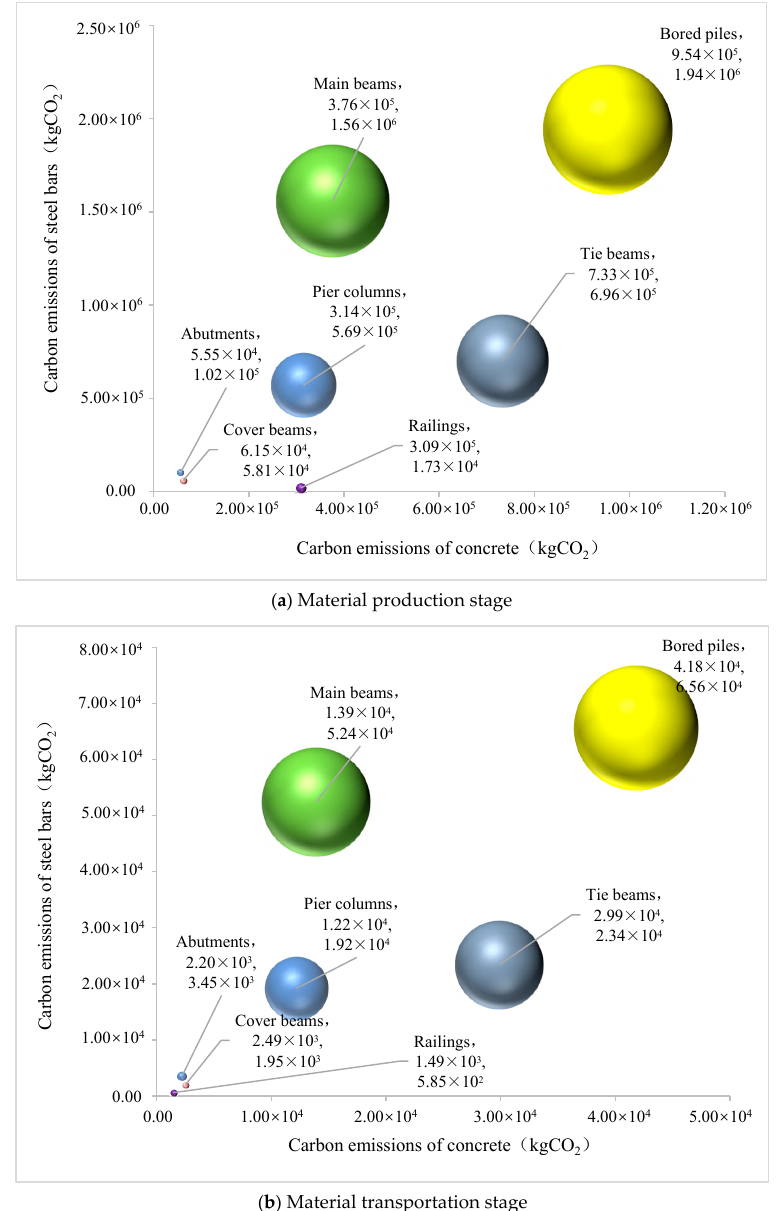
Figure 5. Carbon emissions of different materials at different stages.